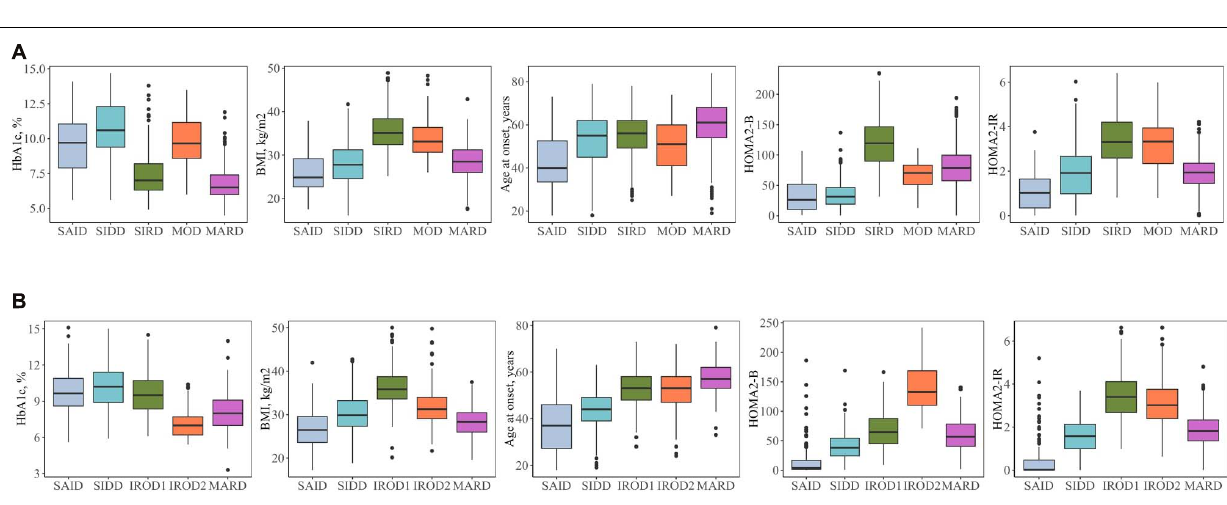
FIGURE 2 | Clinical characteristics of the clusters. (A) Individuals with new-onset adult diabetes with less than 3 years of disease duration ( n = 887). (B) Individuals with long-term adult diabetes with more than 3 years of disease duration ( n = 1,253). SAID, severe autoimmune diabetes ; SIDD, severe insulin-deficient diabetes; SIRD, severe insulin-resistant diabetes; MOD, mild obesity-related diabetes; MARD, mild age-related diabetes; IROD1 and 2, insulin-resistant obese diabetes 1 and 2; HOMA2-B, homoeostatic model assessment two estimates of β -cell function; HOMA2-IR, homoeostatic model assessment two estimates of insulin